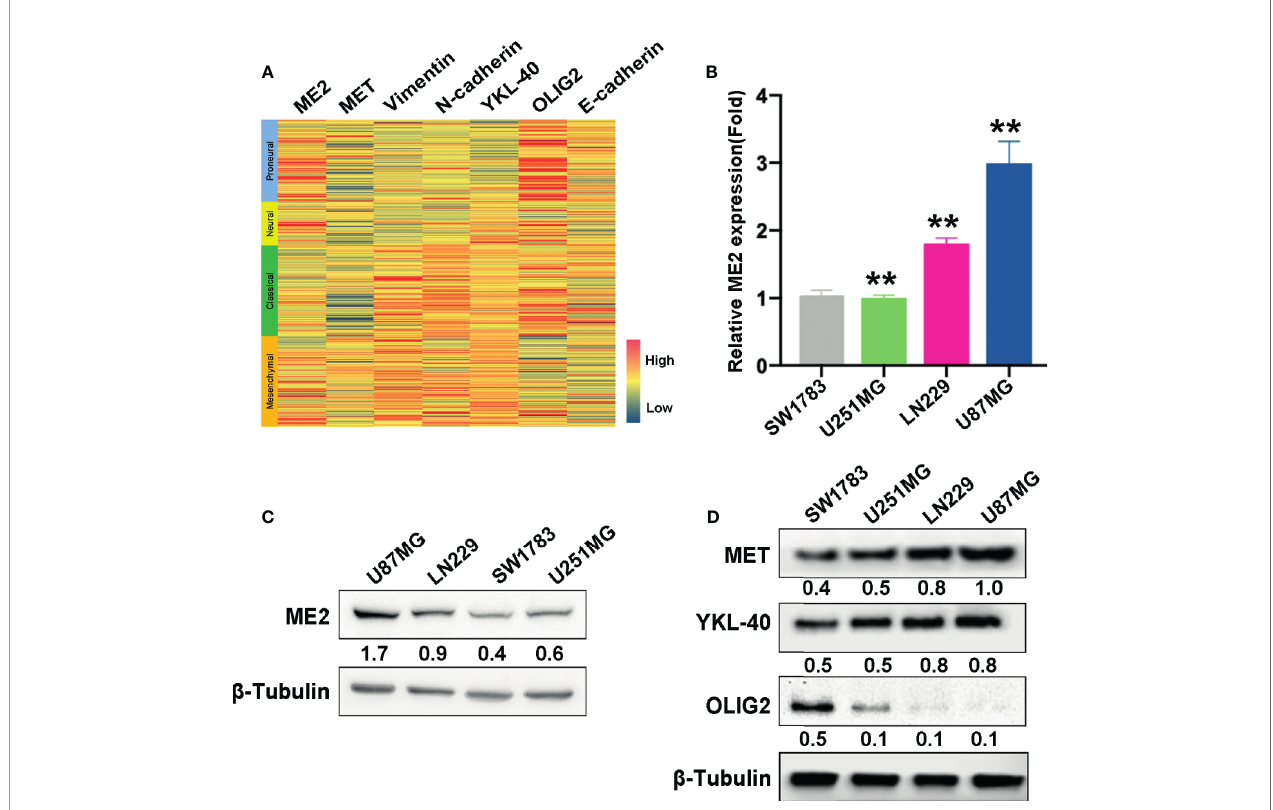
FIGURE 2 | ME2 is positively correlated with mesenchymal features in GBM. (A) Gene expression heat map showing the expression of ME2 and PN and MES markers in different gliomas. (B) mRNA expression levels of ME2 detected by real-time PCR in SW1783, U251MG, LN229, and U87MG cells (n = 4, **P < 0.01).